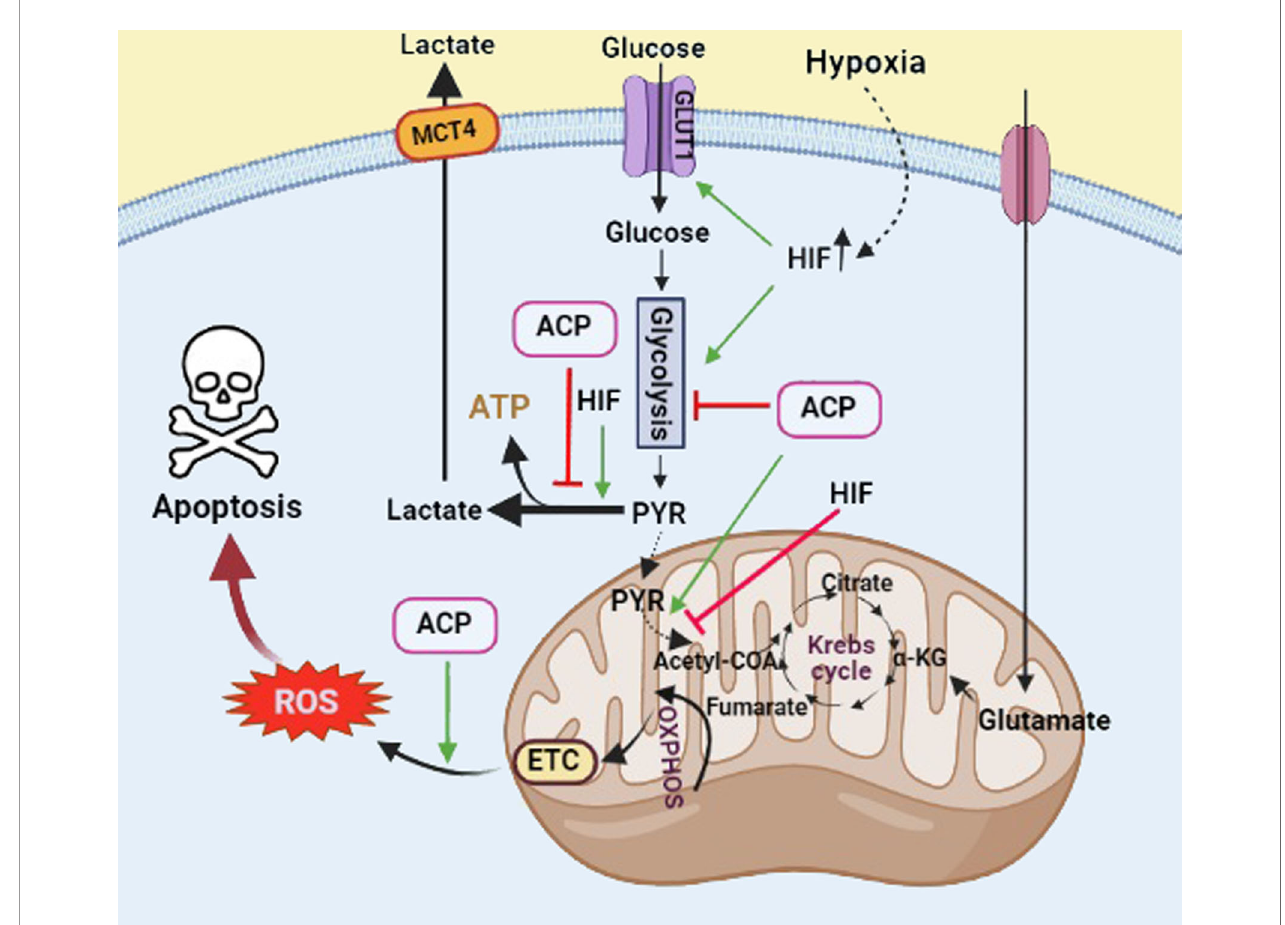
FIGURE 5 | The role of ACPs and HIF in regulation of glucose metabolism in cancer cells. HIF involves the induction of the Warburg effect and glucose transport. ACPs inhibit the glycolysis pathway and induce reactive oxygen species (ROS) production, which leads to cancer cell death through the apoptotic pathway. Black arrows show active glucose metabolic pathways. Green arrows and red T bars show positive and negative impacts on the pathways, respectively. GLUT1, glucose transporter 1; MCT4, monocarboxylate transporter 4 (Created with